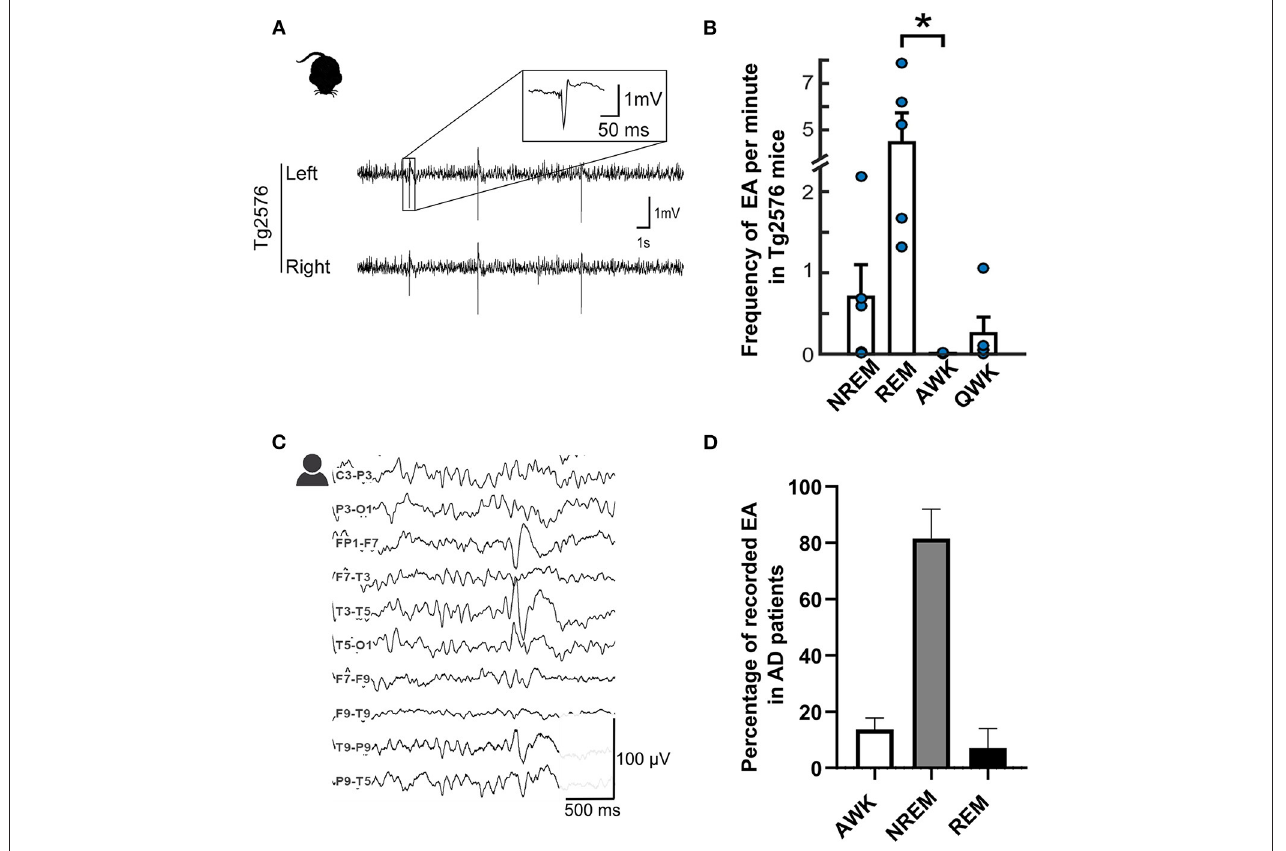
FIGURE 1 | Epileptiform spikes in AD patients and the Tg2576 mouse model. (A) Representative examples of EA in Tg2576 mice (Power 1401 mk-II, CED, Cambridge, UK). Reproduced from (22) with permission (B) Distribution of epileptiform events in Tg2576 mice over the sleep-wake cycle in 6-week-old ( n = 10, blue) and 6-month-old ( n = 7, red) animals. Reproduced and adjusted from ( 23) with permission. (C) Longitudinal view of an epileptiform discharge during a vEEG examination, recorded from an AD patient at the University Hospital of Toulouse (Natus, Pleasanton, CA, USA). Calibration bar: 100 µ V, 500ms. (D) Distribution of epileptiform discharges in AD patients in the studies reporting IED prevalence with awake and sleep-related data ( 24–26). For (24), data is pooled from AD patients with and without known epilepsy. Note that REM frequency was not reported for ( 25) and NREM stages were pooled together to account for differences in reporting